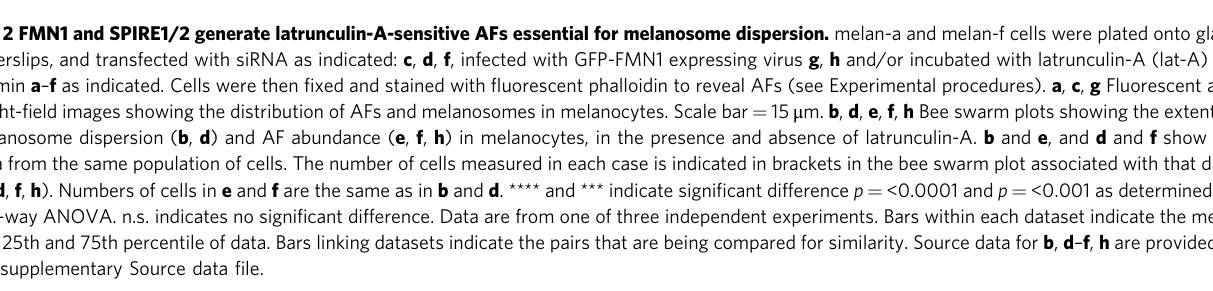
Fig. 2 FMN1 and SPIRE1/2 generate latrunculin-A-sensitive AFs essential for melanosome dispersion. melan-a and melan-f cells were plated onto glass coverslips, and transfected with siRNA as indicated: c , d , f , infected with GFP-FMN1 expressing virus g , h and/or incubated with latrunculin-A (lat-A) for 60 min a – f as indicated. Cells were then fi xed and stained with fl uorescent phalloidin to reveal AFs (see Experimental procedures). a , c , g Fluorescent and bright- fi eld images showing the distribution of AFs and melanosomes in melanocytes. Scale bar = 15 μ m. b , d , e , f , h Bee swarm plots showing the extent of melanosome dispersion ( b , d ) and AF abundance ( e , f , h ) in melanocytes, in the presence and absence of latrunculin-A. b and e , and d and f show data from the same population of cells. The number of cells measured in each case is indicated in brackets in the bee swarm plot associated with that data ( b , d , f , h ). Numbers of cells in e and f are the same as in b and d . **** and *** indicate signi fi cant difference p = <0.0001 and p = <0.001 as determined by one-way ANOVA. n.s. indicates no signi fi cant difference. Data are from one of three independent experiments. Bars within each dataset indicate the mean and 25th and 75th percentile of data. Bars linking datasets indicate the pairs that are being compared for similarity. Source data for b , d – f , h are provided in the supplementary Source data fi